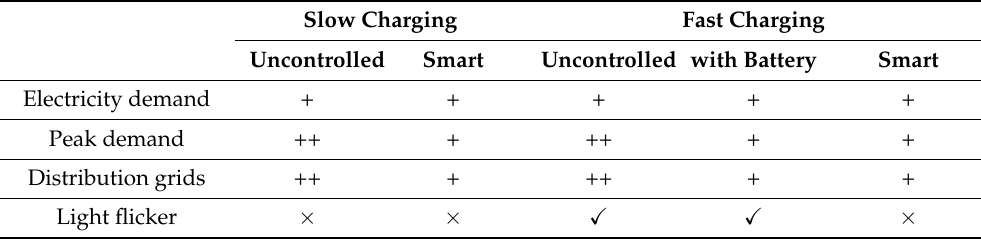
Table 2. Impact of charging method and type